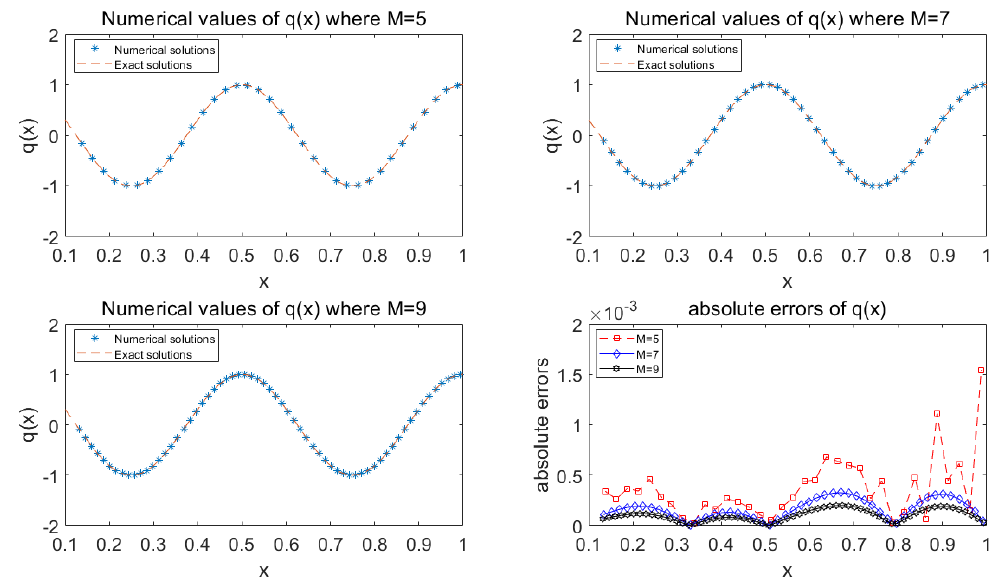
Figure 1. Numerical values of q ( x ) and absolute errors between the approximation and exact solutions of q ( x ) with k = 4 and M = 5, 7, 9 in Example